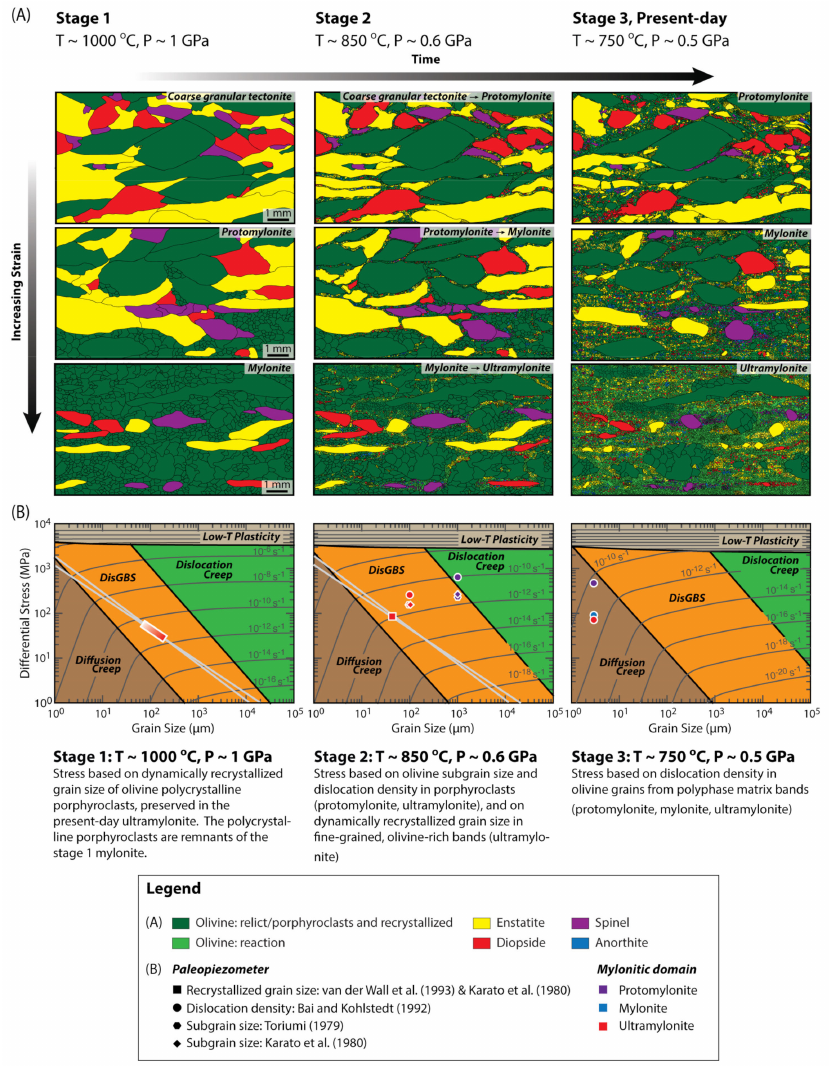
Figure 8. ( A ) Microstructural evolution of Turon de T é cou è re peridotite as temperatures and pres- sures decreased from conditions of ~1000 ◦ C at ~1.0 GPa to ~750 ◦ C at ~0.5 GPa. The coarse granular tectonite, protomylonite, and mylonite domains of Stage 1 evolved into the present-day (Stage 3) protomylonite, mylonite, and ultramylonite, respectively. ( B ) Olivine deformation mechanism maps constructed using the flow laws of [88,89]. We used the piezometric calibrations of [72,73] (grey lines), to show the relationship between recrystallized grain size and differential stress (in Stage 1 and 2). The symbols plotted on the maps correspond to the stresses estimated by the different paleopiezometers and to the mean grain size of the load-bearing